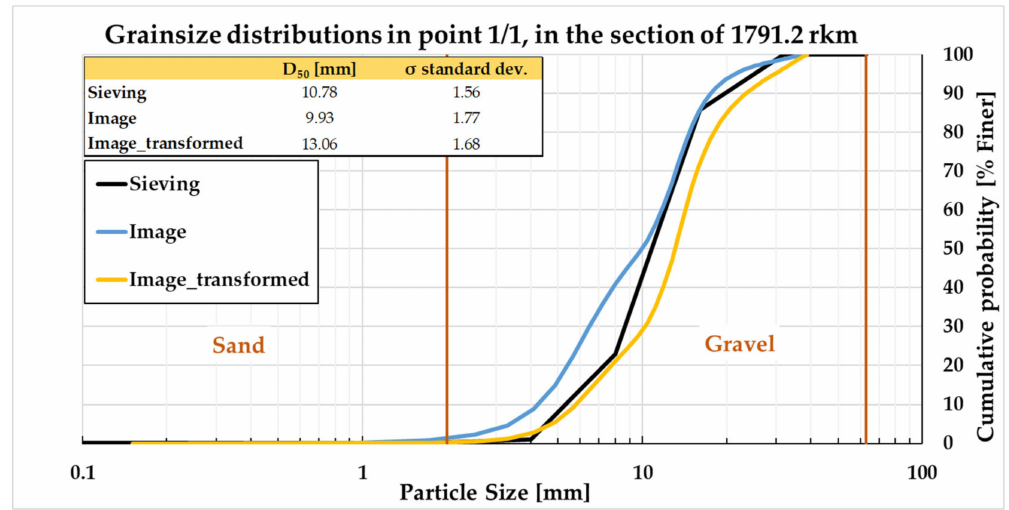
Figure 8. Size distributions of sampling point 1 / 1. The image-based distribution showed a good match with the sieving results, with the closest matches being on the upper end of the curves. After transforming it, the closest matches turned out to be on the lower tail of the curves, but the shape resemblance became stronger